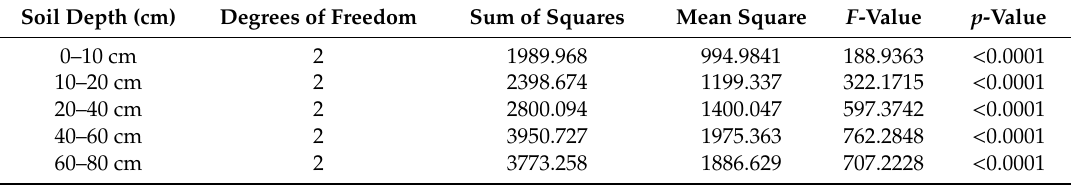
Figure 5. Analysis of soil temperature at different soil depths under different vegetation types during the growing season. The statistical differences are shown using a, b, and c ( n = 120). Table 3. Comparison of soil temperature at different depths by one-factor analysis of variance.